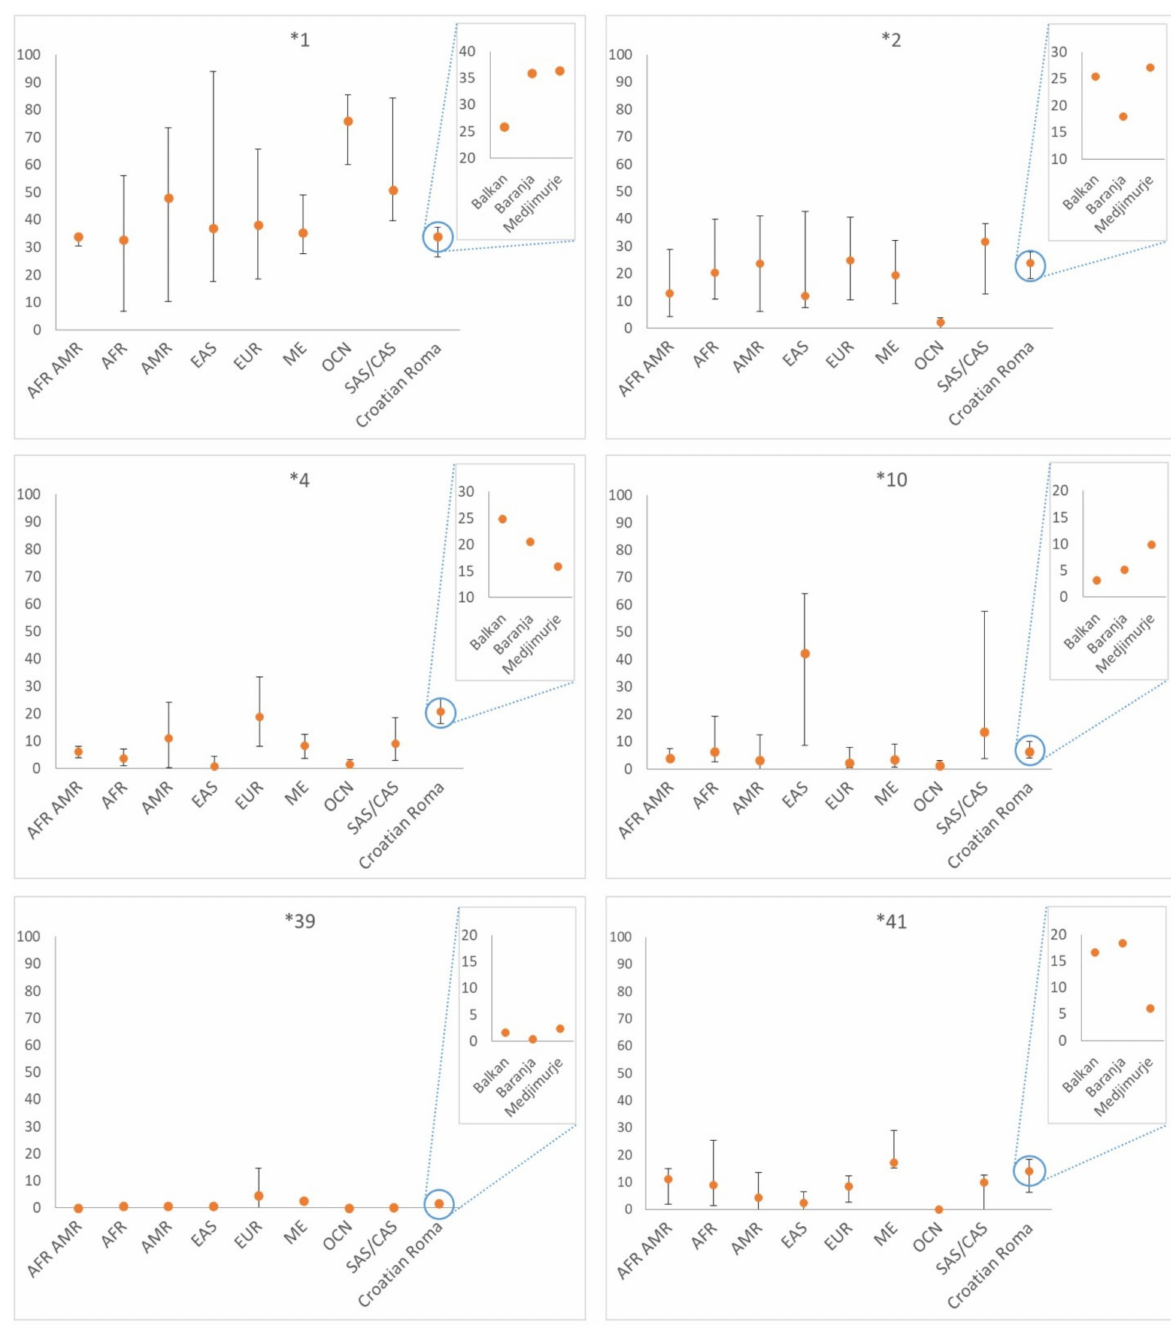
Figure 4. Distribution of *1 , *2 , *4 , *10 , *39 , *41 alleles frequencies in Croatian Roma and major human populations groups (abbreviations: AFR AMR—African Americans, AFR—Africa, AMR—Americas, OCN—Oceania, EAS—East Asia, SAS/CAS—South/Central Asia, ME—Middle East,